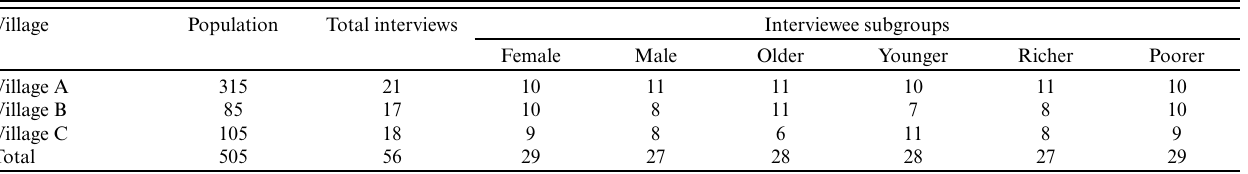
Table 1. Interview statistics across